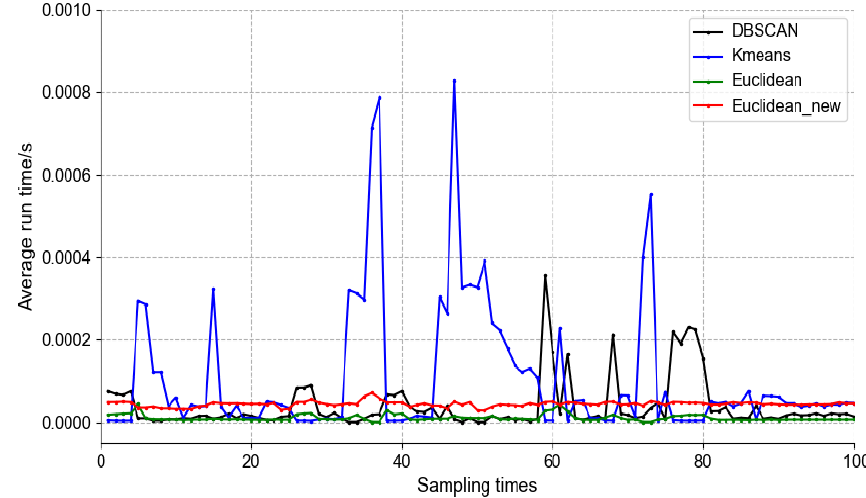
Figure 13. Analysis algorithm’s average time-consumption.